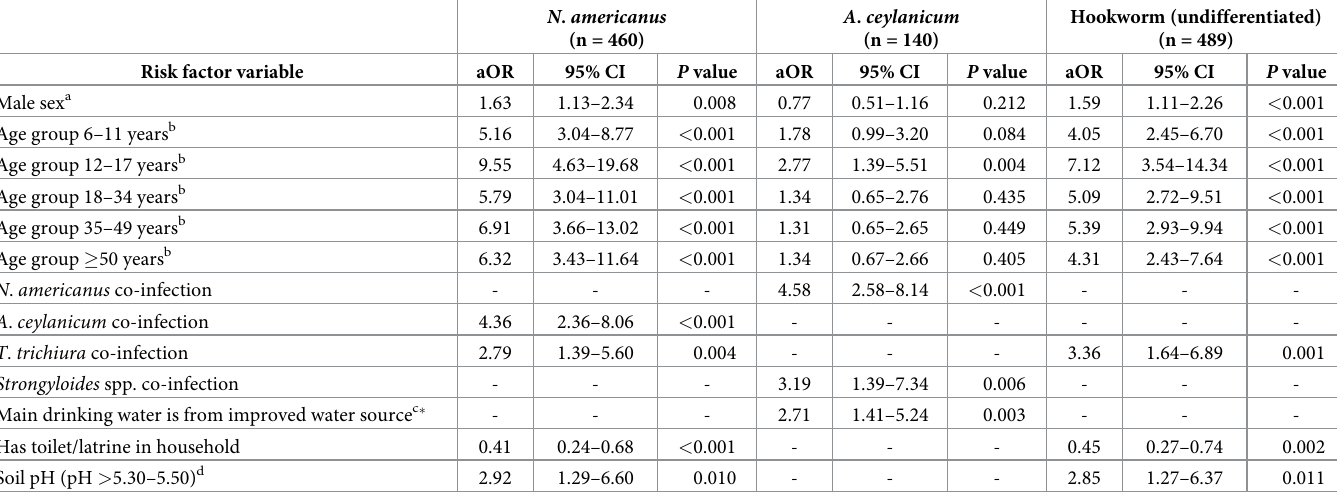
Table 4. Risk factors associated with N . americanus , A . ceylanicum , and undifferentiated hookworm infection.